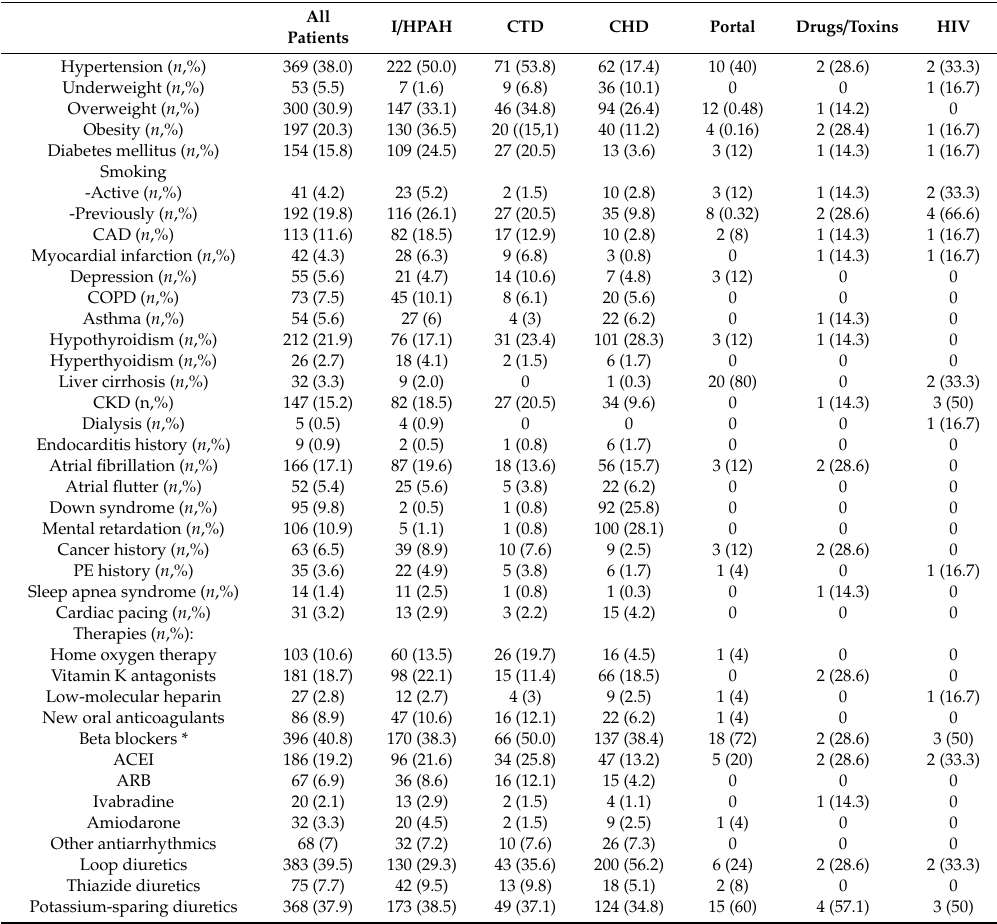
Table 5. Concomitant diseases and their